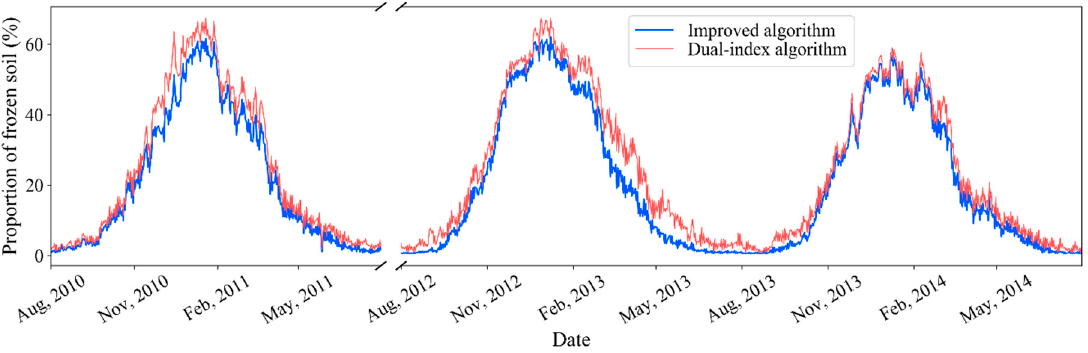
Figure 9. The areal proportions of the frozen soil over the study periods derived from the improved and original DIA, respectively.